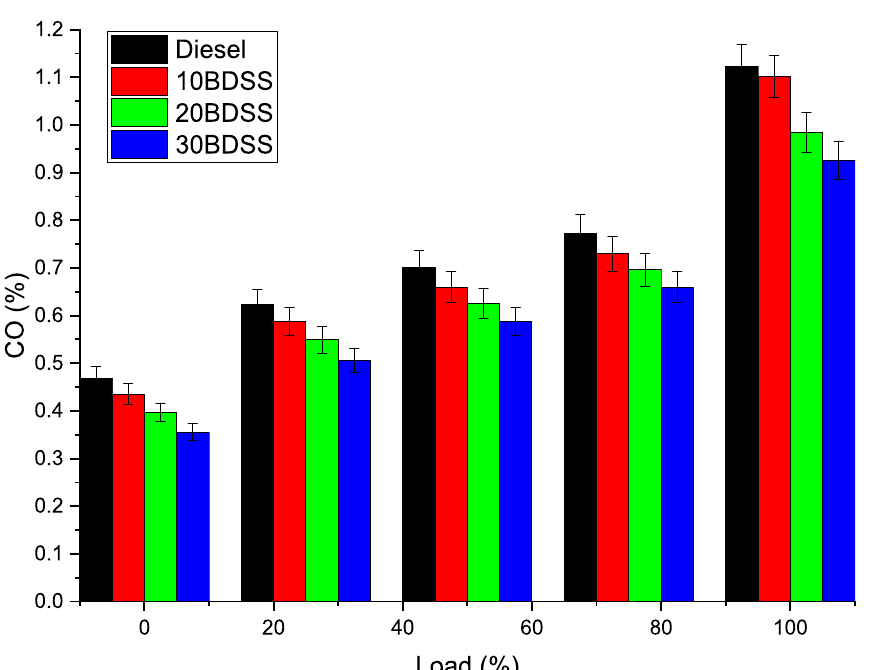
Figure 9. Influence of biodiesel blends in CO